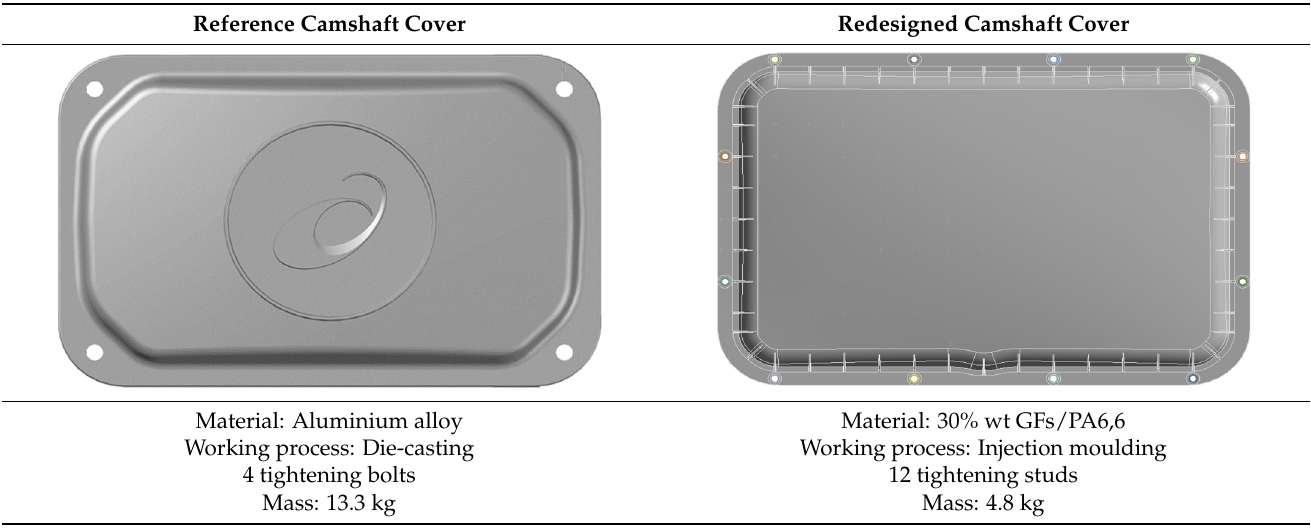
Table 2. Comparison between reference and redesigned component.